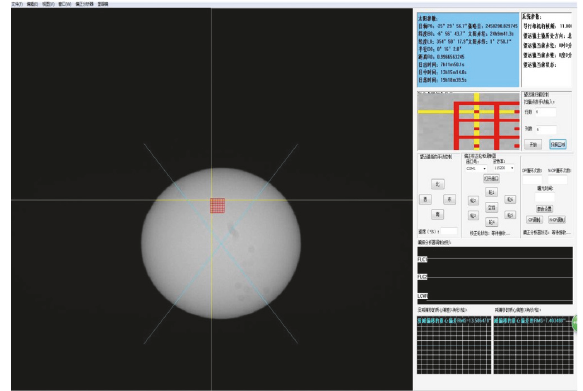
Figure 8: The graphical user interface of controlling system of our proposed scanning method based on autoguiding system on the computer screen.